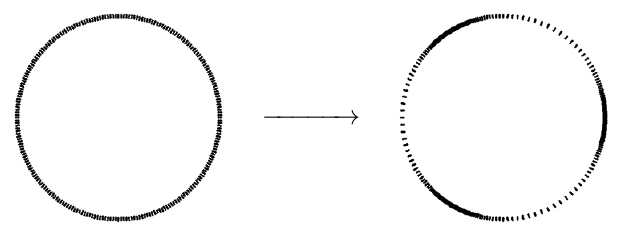
Figure 2 . A circle with uniformly spaced dots is acted upon by a superboost (4.12) of order n = 3 with positive (cid:21) . The dots converge towards the points ’ = 0 ; 2 (cid:25)= 3 ; 4 (cid:25)= 3 and move away from ’ = (cid:25)= 3 ; (cid:25); 5 (cid:25)= 3. Analogous observations apply to all